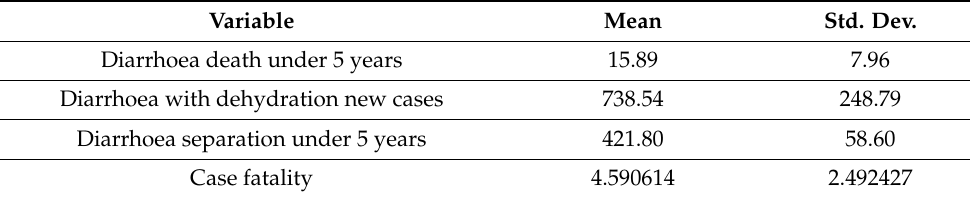
Table 1 indicates Limpopo with the least compliance status of 88.55 for microbial water quality with an aggregate of 21.59 for children under 5 years mortality rates. Table 1 indicates the highest compliance statuses for microbial water quality in the Western Cape, Gauteng, KwaZulu-Natal, and Northern Cape provinces, with aggregates over 99% and their corresponding under 5 years mortality rates, which were lower with aggregates of 2.15 for Northern Cape and Western Cape, followed by 11.79 and 30.09 for Gauteng and KwaZulu-Natal, respectively (Table 1). Limpopo had the lowest compliance status of 88.6% with an aggregate of 21.59 for under 5 years mortality rates, while Eastern Cape and KwaZulu-Natal had the highest average for under 5 years mortality rates and the highest average compliance statuses for the period 2008 to 2018 (Table 1). Table 2 indicates the highest average of 738 (SD = 248) new cases of diarrhoea with dehydration between 2008 and 2018 and the lowest average for the child under 5 years diarrhoea case fatality rate, which was 5 per 1000 cases between 2008 and 2018 (Table 2). Table 2. Descriptive statistics for diarrhoea in children under the age of 5 years in South Africa (N =